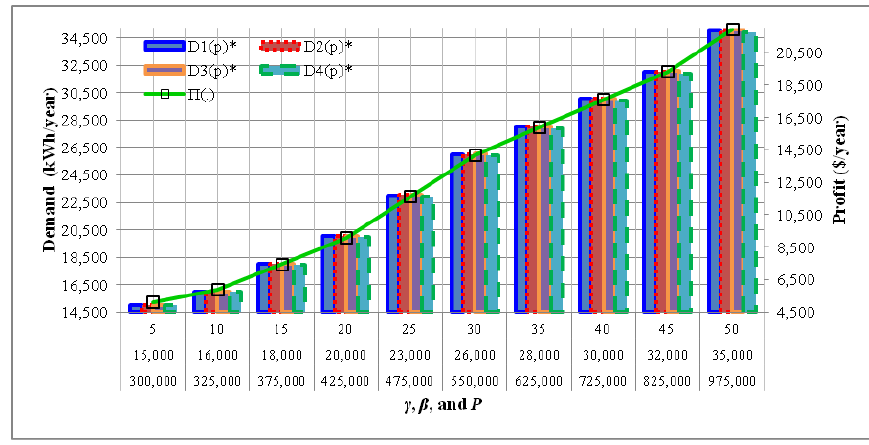
Figure 7. The Effect of Simultaneous Changes in the Power Supply Rate, Scaling Factor and Price Elasticity Coefficient on Profitand Demand.